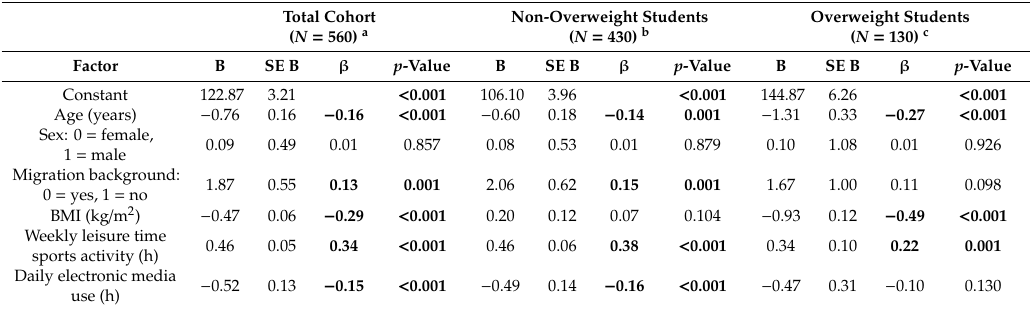
Table 2. Results of the multiple linear regression analysis of factors associated with physical fitness (total Z-score) in the total cohort, in non-overweight students and in overweight students. Total Cohort Non-Overweight Students Overweight Students ( N = 560) a ( N = 430) b ( N = 130) c Factor B SE B β p -Value B SE B β p -Value B SE B β p -Value Constant 122.87 3.21 < 0.001 106.10 3.96 < 0.001 144.87 6.26 0.18 − 0.14 0.001 − 1.31 0.33 − 0.27 0.09 0.49 0.01 0.857 0.08 0.53 0.01 0.879 0.10 1.08 0.12 0.07 0.104 − 0.93 0.12 − 0.49 − 0.15 < 0.001 − 0.49 0.14 − 0.16 < 0.001 − 0.47 0.31 − 0.10